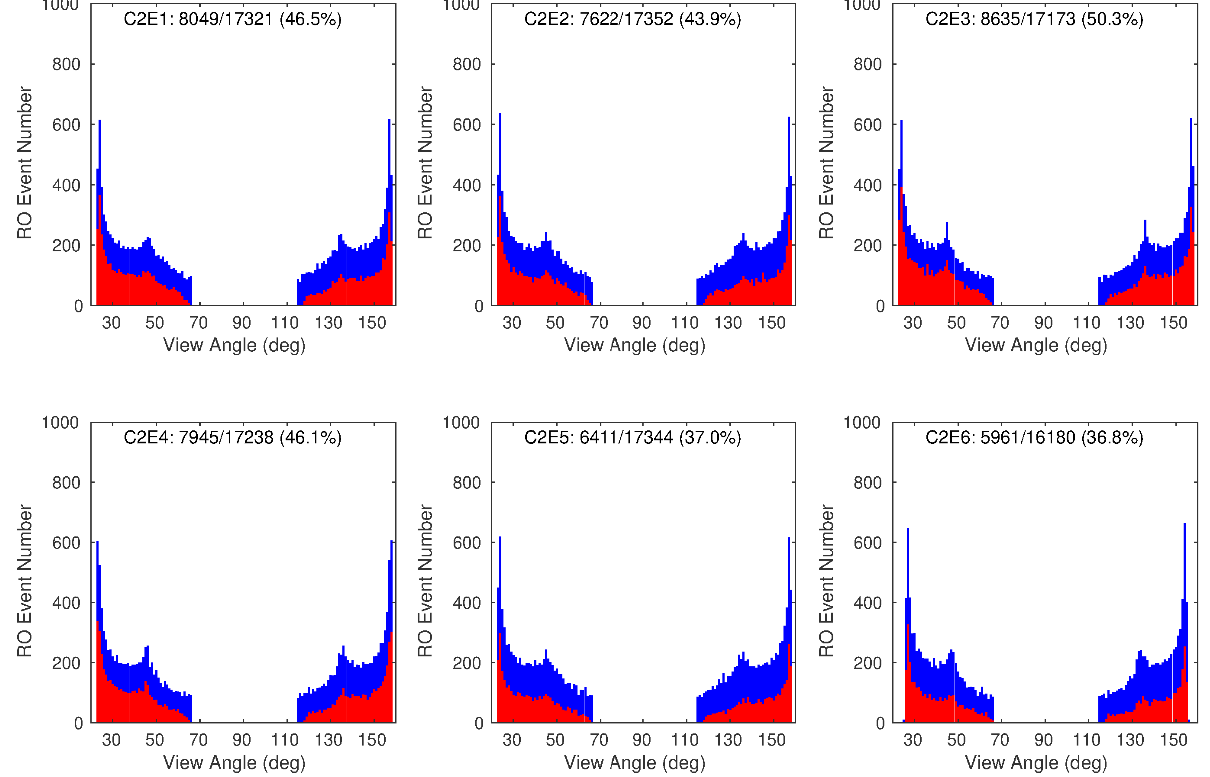
Figure 6. Same as Figure 5, but for GLONASS satellites.